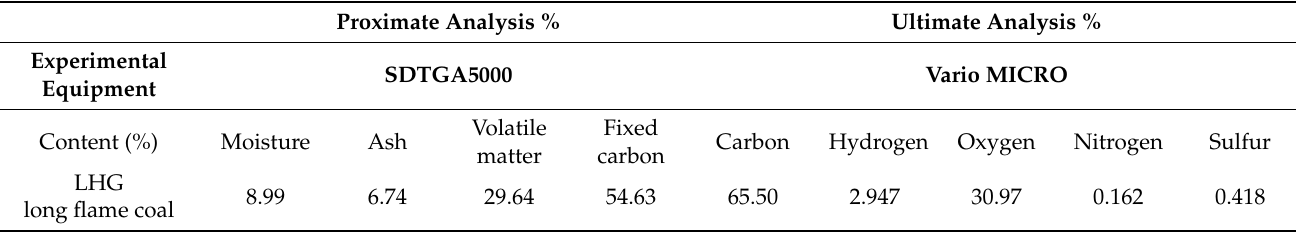
Table 1. Proximate and ultimate analyses of coal